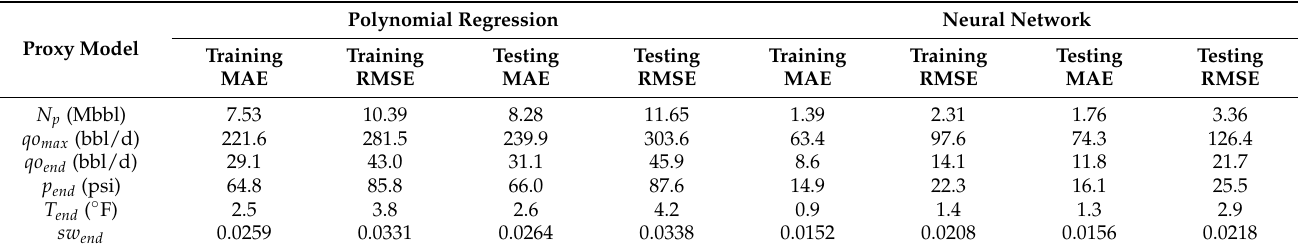
Table 5. Summary of training and testing mean absolute error (MAE) and root mean square error (RMSE) for each proxy